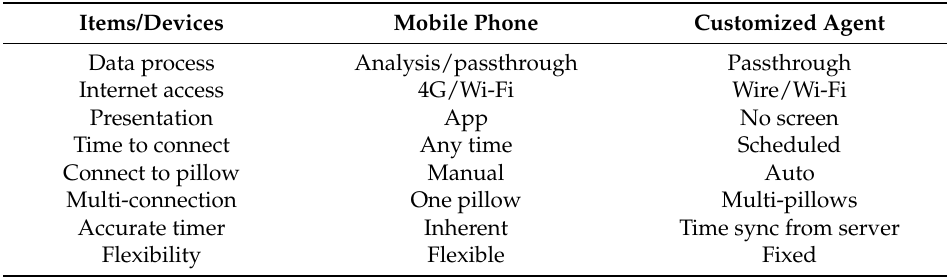
Table 1. Comparison of using mobile phone versus customized transport agent.